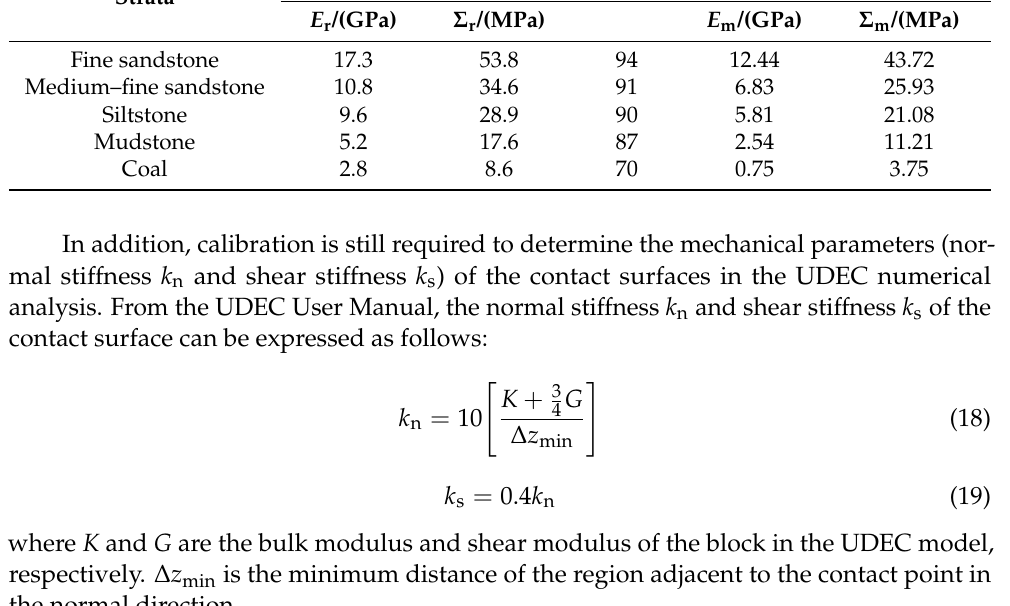
Table 2. Mechanical properties of the complete rock mass and computational rock mass. Complete Rock Samples Strata